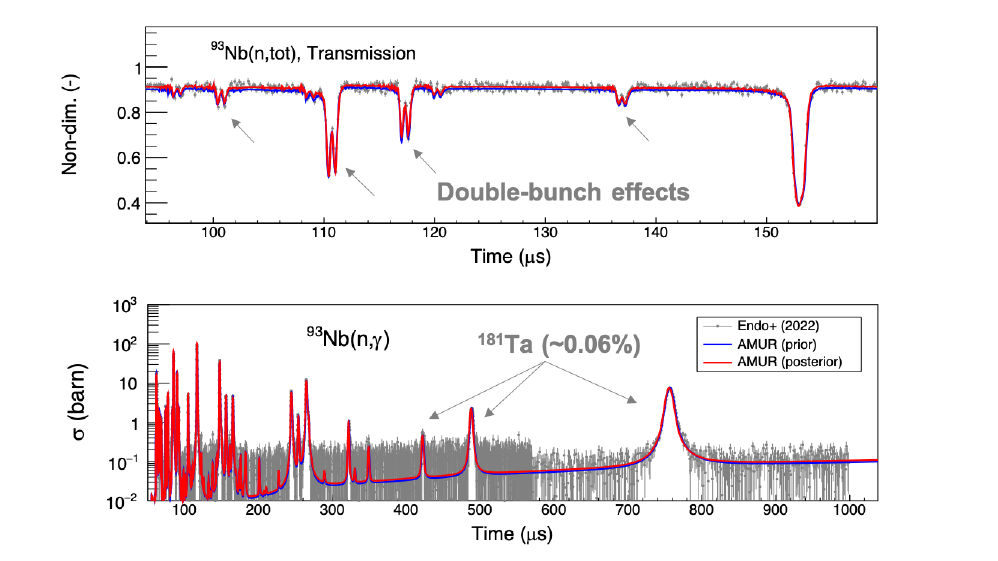
Figure 4. Fitting results to the experimental TOF spectra on transmission and (n, γ ) cross-sections measured at J-PARC / ANNRI.